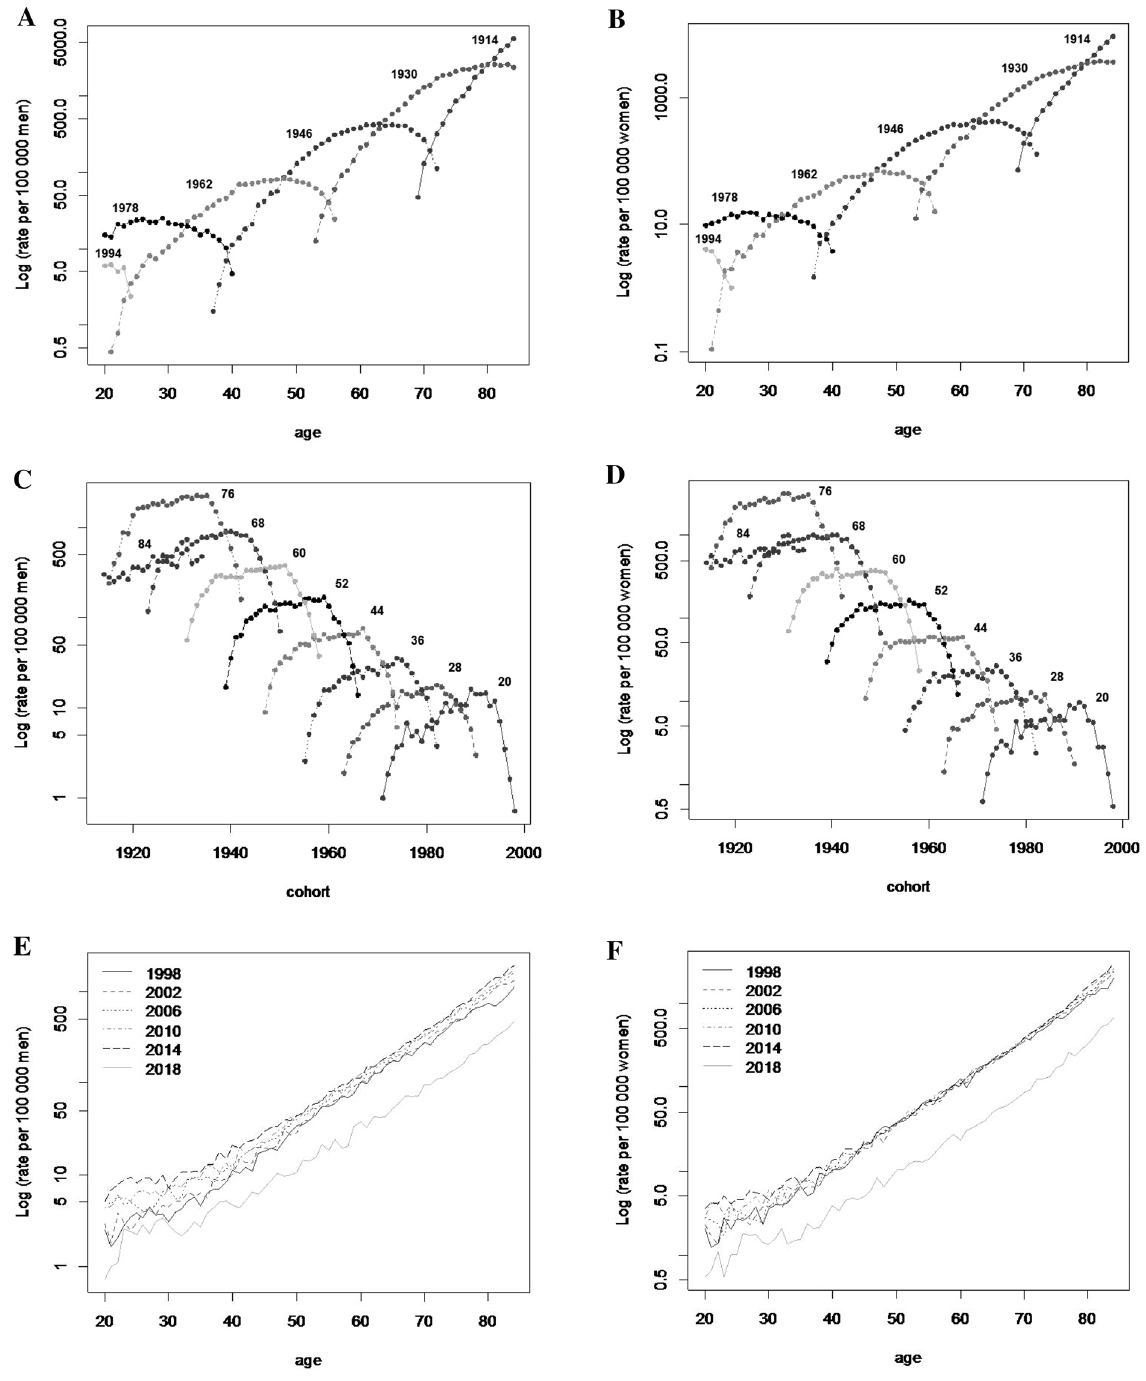
Figure 3. Hypertension mortality curves by age-specific within birth-year cohort and sex. Mexico, 1998–2018. Age-specific within cohort ( A ) Men, ( B ) Women. Birth-year cohort within age-specific ( C ) Men, ( D ) Women. Age-specific within period ( E ) Men, ( F )